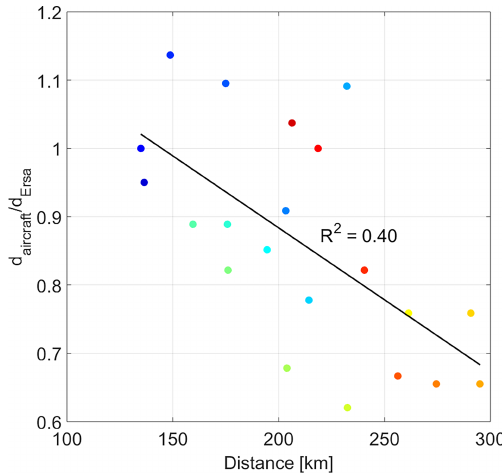
Figure 14. Ratio of nucleation-mode diameters measured onboard the ATR-42 over that calculated in Ersa as a function of the distance between the aircraft and Ersa on 1 August. The color coding of this scatter plot matches with the location of the aircraft showed in the insert of the left panel of Fig.